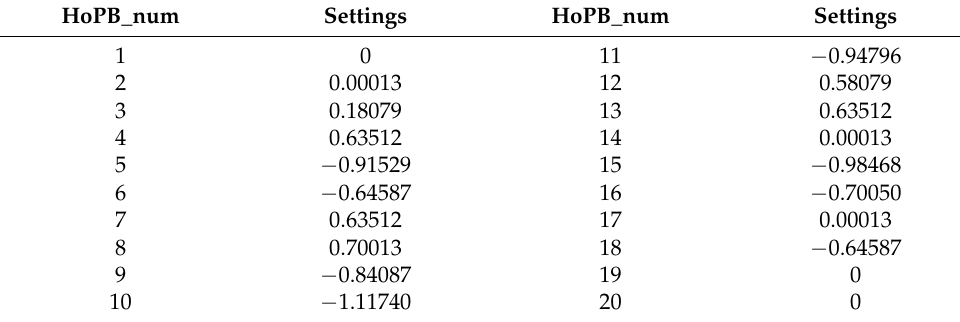
Table 4. Fuzzy Inference